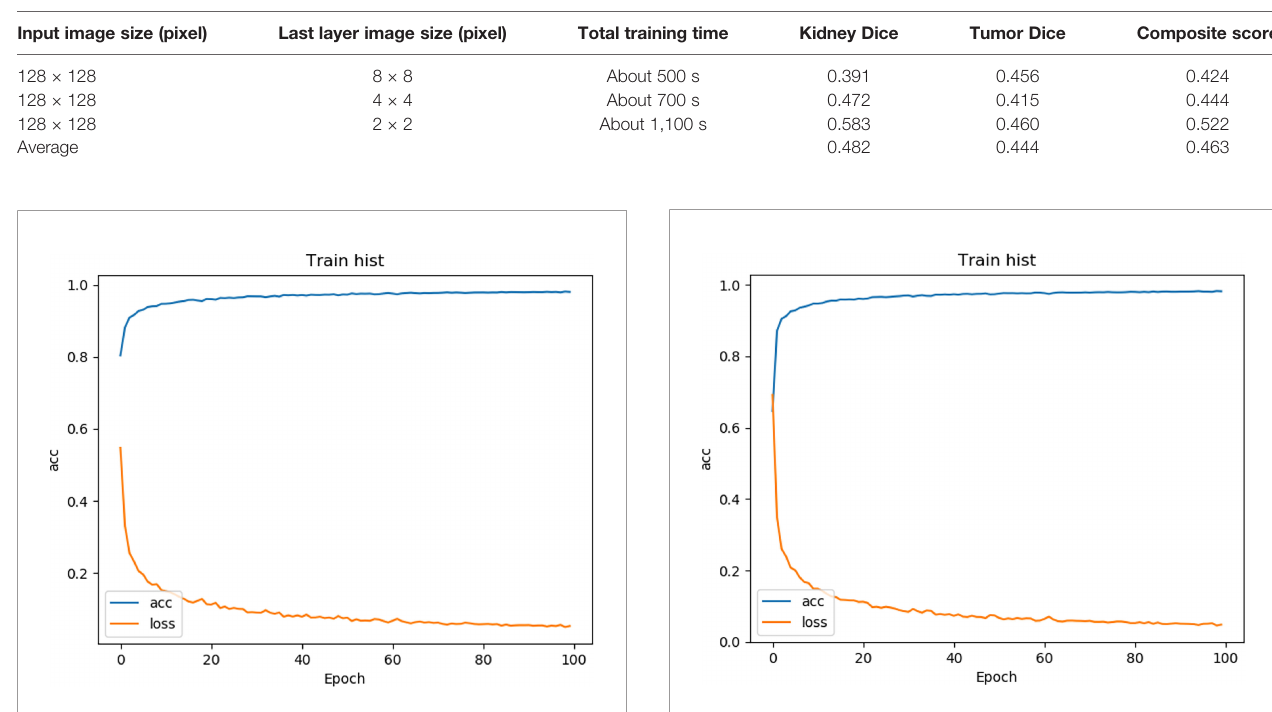
TABLE 1 | Fine segmentation based on U-Net model.